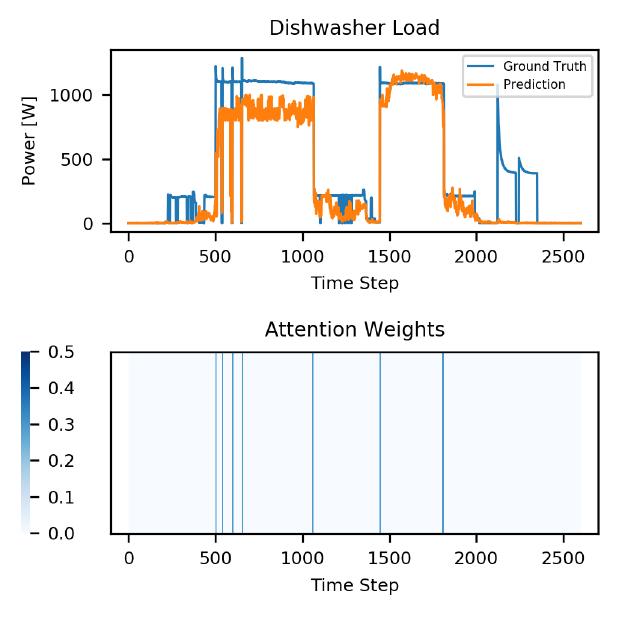
Figure 4. REDD dishwasher load and the heatmap of the attention weights at 3 s resolution.